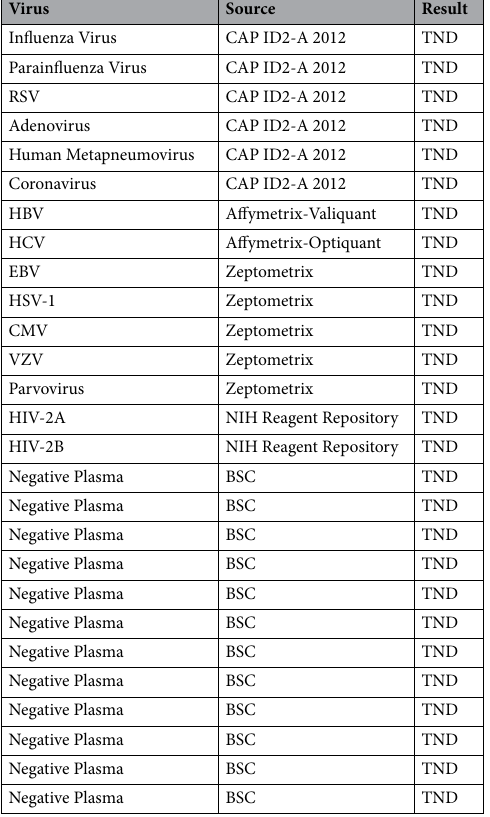
Table 4. Specificity of assay on plasma samples from individuals infected with other viruses or from uninfected individuals. *TND target not detected.